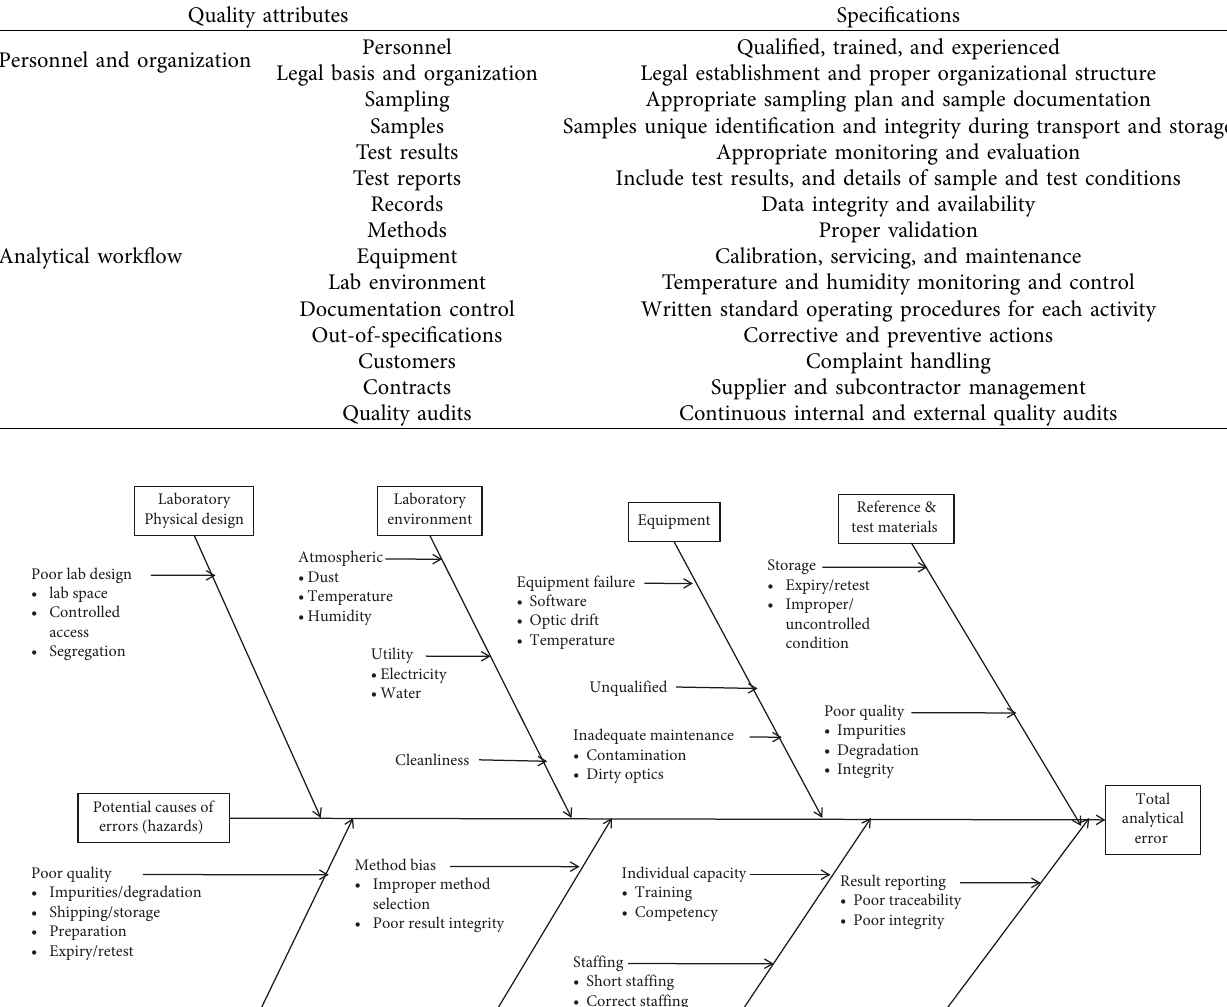
Table 2: WHO quality requirements implemented in JuLaDQ [34].